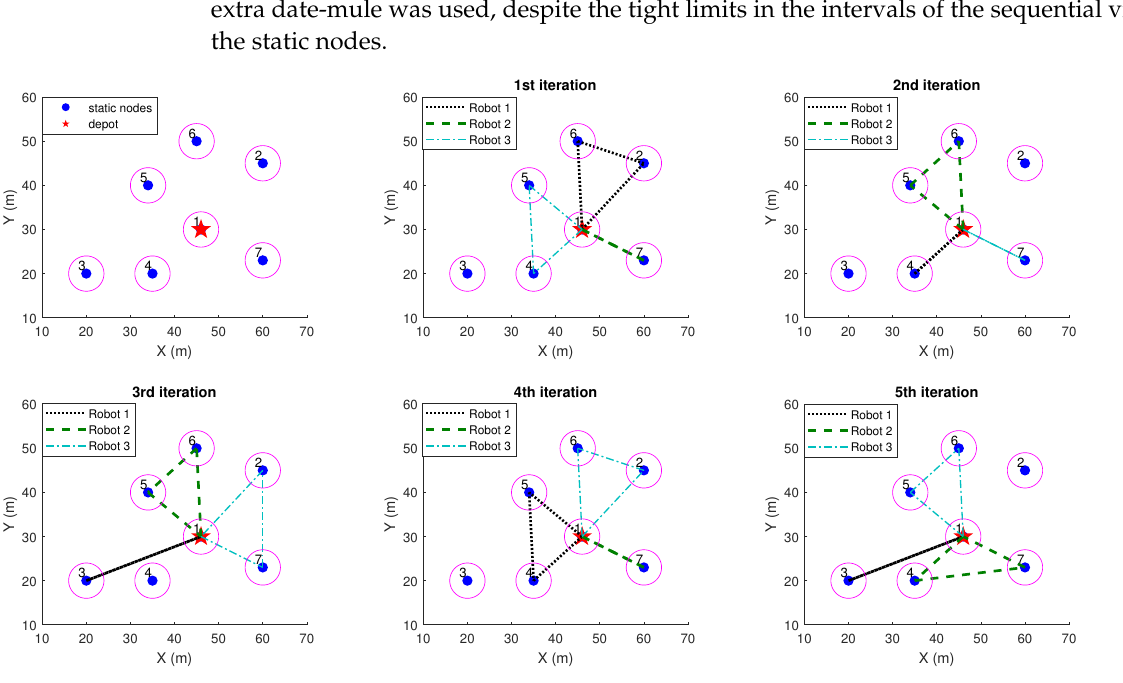
Figure 3. Mobile Element Scheduling Routes with 3 MoEls and 7